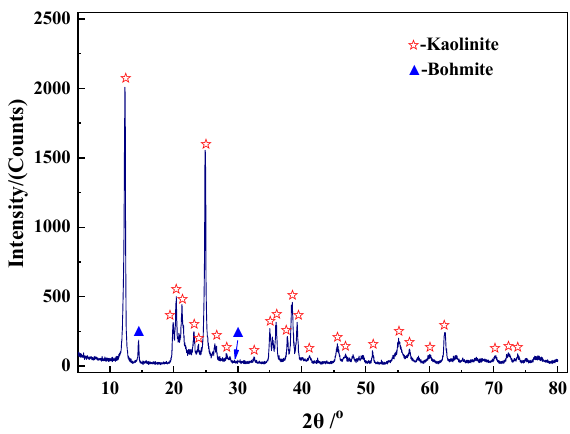
Figure 1. XRD analysis spectrum of CSK.